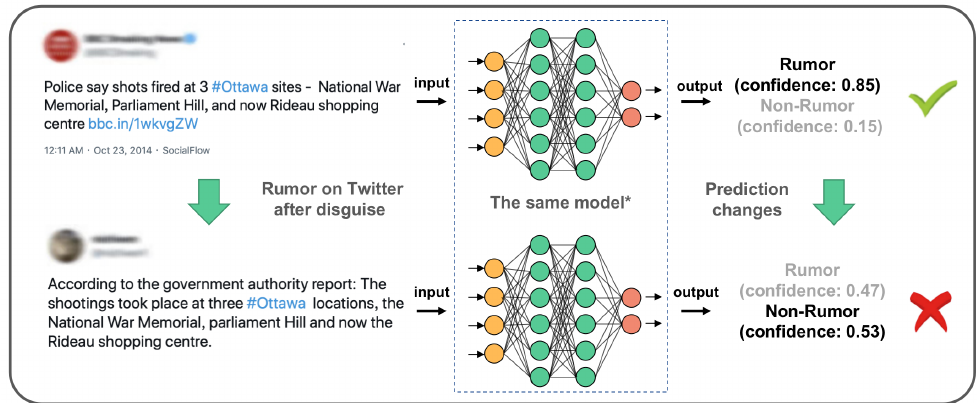
Figure 1. A well-trained BERT-base (The BERT-base code is completed by Hugging Face (https: //github.com/huggingface/transformers (accessed on 8 May 2022)) on model for rumor detection. The rumor detection model labeled a rumor as a non-rumor when the words underwent small changes but the meaning remained the